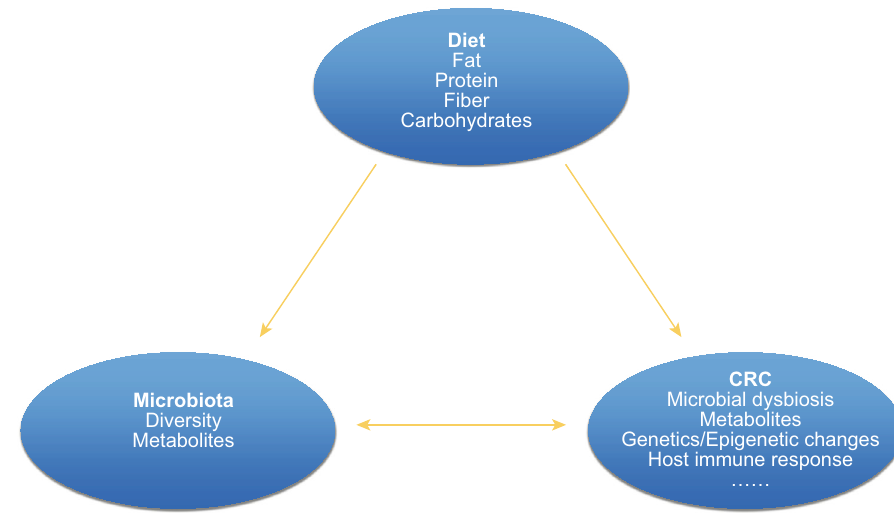
Figure 1. Theassociation ofdiet,gutmicrobiotaand